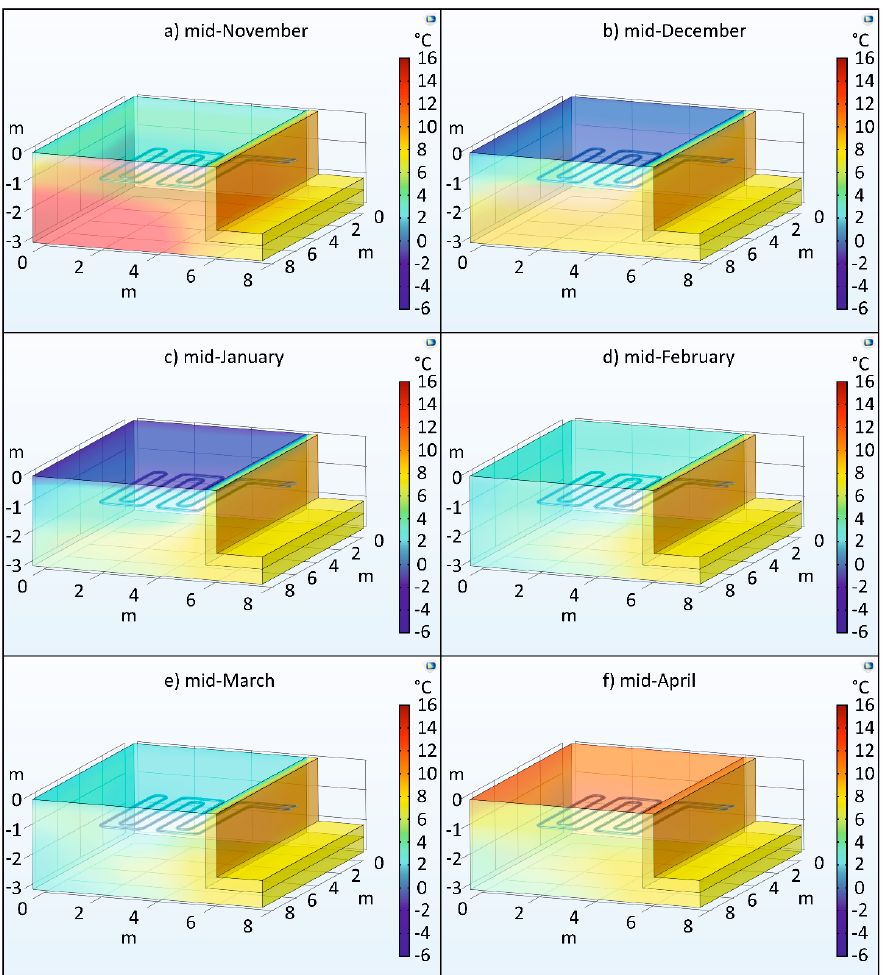
Figure 7. The tri-dimensional temperature gradients for the simulation case 3—HGHE with heat from solar thermal panels: ( a ) mid-November; ( b ) mid-December; ( c ) mid-January; ( d ) mid-February; ( e ) mid-March; ( f ) mid-April.